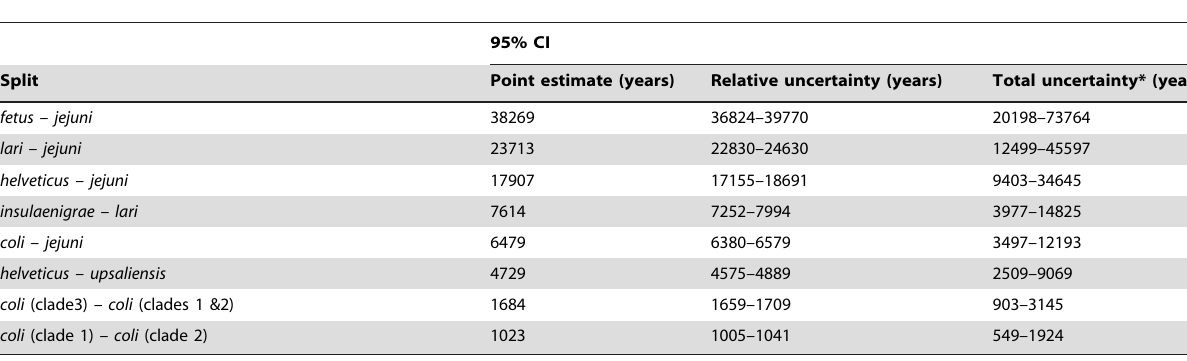
Table 2. Estimates of the time of Phylogenetic splits in the genus Campylobacter